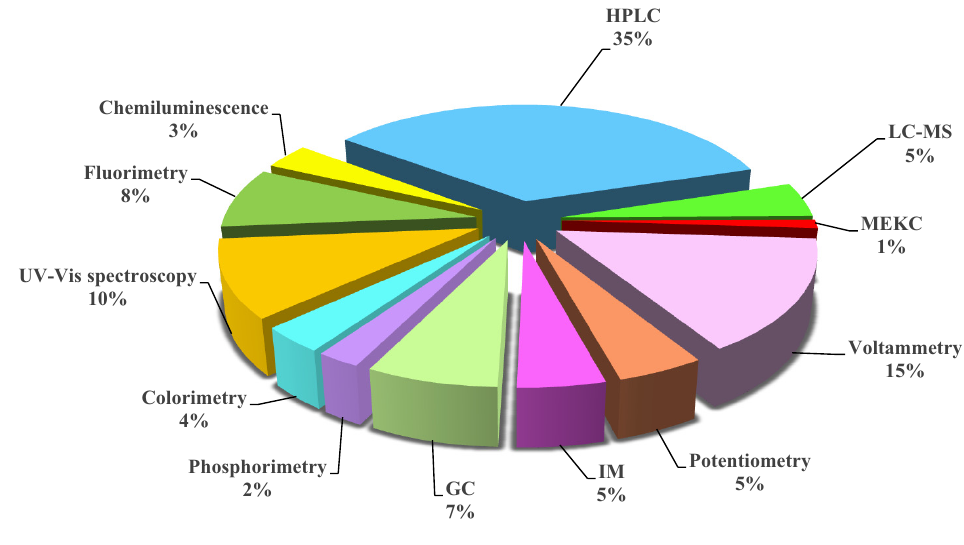
Figure 4: Distribution of analytical methods described in the literature for INDO determination in period between 1965 and